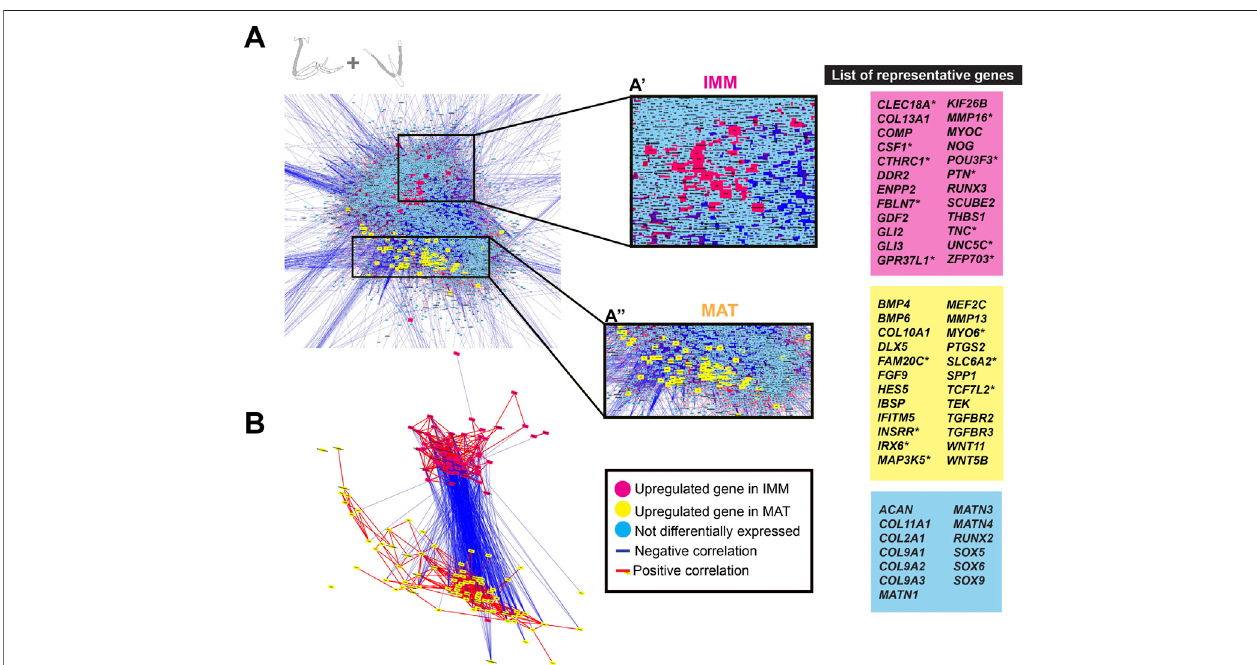
FIGURE4| GCNofcombinedlimbandheadchondrocytedatawasorganizedintogroupsofenrichedIMMorMATgenesthatwerenegativelycorrelatedwitheach other. (A) A GRN underlying chondrocyte differentiation was estimated from a GCN from limb and head chondrocytes (normalized together). One portion of the GRN contained genes upregulated in IMM (pink nodes), while another portion contained genes upregulated in MAT (yellow nodes). Typical chondrocyte differentiation genes included in the network (light blue nodes) were not differentially expressed between IMM and MAT. Representative lists of genes in each of these three categories are shown to the side of the GRNs. These candidate genes were selected because they are known to have a role during cartilage differentiation in different vertebrates, and they arelisted inalphabetical order. Putative novelgenesareindicatedbyanasterisknexttothegenename. (B) Isolated portions ofIMM- andMAT-enriched genes in the GRN. Most upregulated genes in IMM or MAT were connected by positive interactions (red lines), whereas IMM and MAT genes were mostly connected by negative interactions (blue lines).